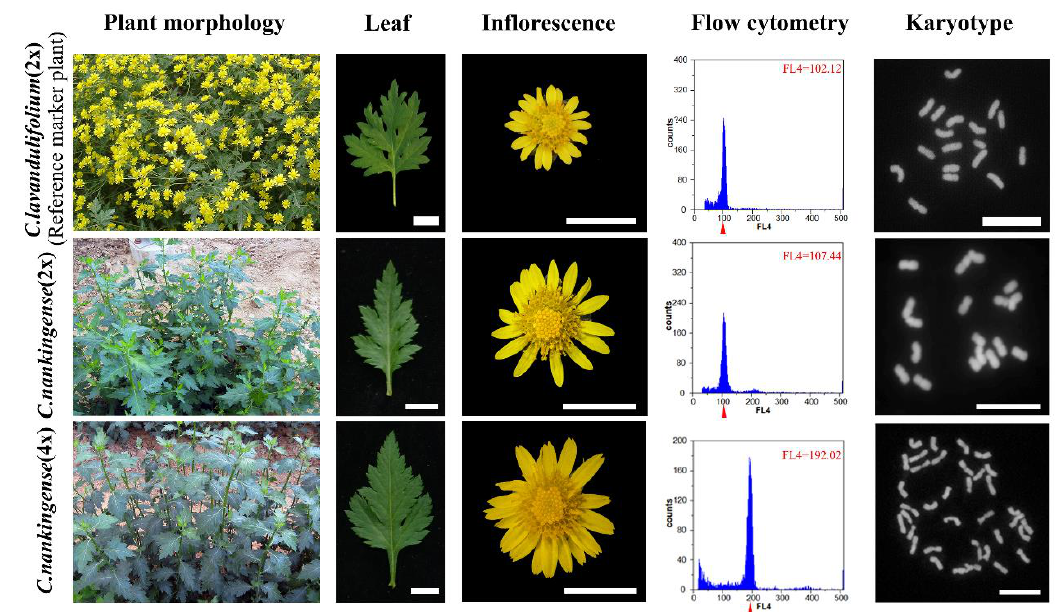
Figure 1. Identification of materials using flow cytometry, cytogenetics (bar = 10 μm), and morphology (bar = 1 cm). (The reference peak of diploid materials is 100 in flow cytometry examination.).